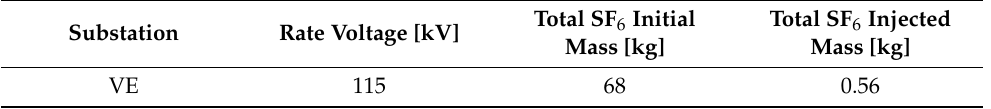
Table 3. Data handling stage results